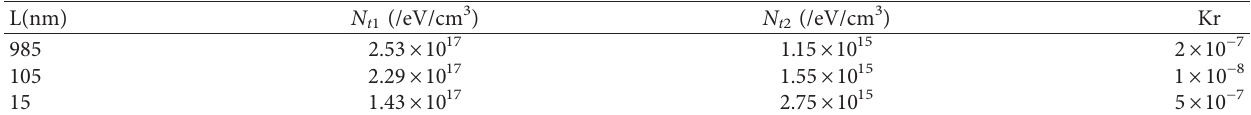
Figure 5: (a) Plots of S 2 experimental data versus I Id / I d d , at frequency 10 Hz, and in front gate mode and (b) plots of S Vg experimental data versus ( V g - V th )/[1- θ 2 ∙ ( V g - V th ) 2 ] with corresponding data fit lines. Table 2: Extracted main noise fitting parameters (uncertainty estimation: ±